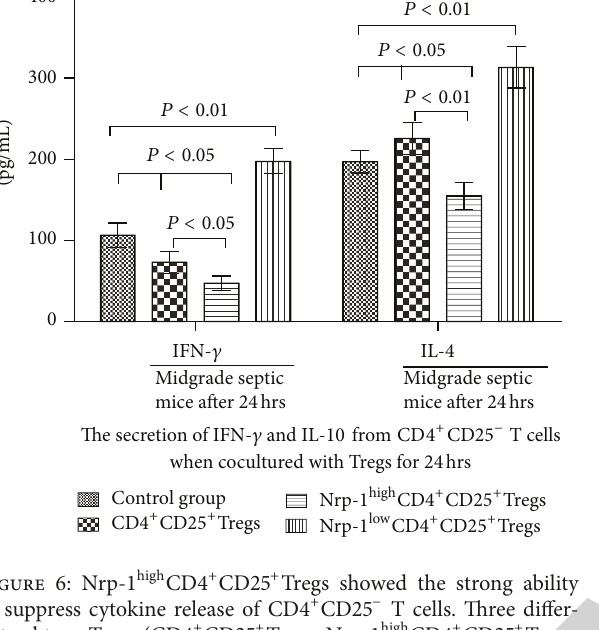
Figure 6: Nrp- 1 high CD4 + CD25 + Tregs showed the strong ability to suppress cytokine release of CD4 + CD25 − T cells. Three differ- ent subtype Tregs (CD4 + CD25 + Tregs, Nrp- 1 high CD4 + CD25 + Tregs, and Nrp- 1 low CD4 + CD25 + Tregs) were cocultured with CD4 + CD25 − T cells for 24 hours, and the secretion of IFN- 𝛾 and IL-4 of CD4 + CD25 − T cells was measured. Data was represented as mean ± standard deviation (SD) and analyzed by SPSS 17.0 software with a one-way ANOVA, 𝑛 = 4 per group ( 𝑃 < 0.05 or 𝑃 < 0.01 ).